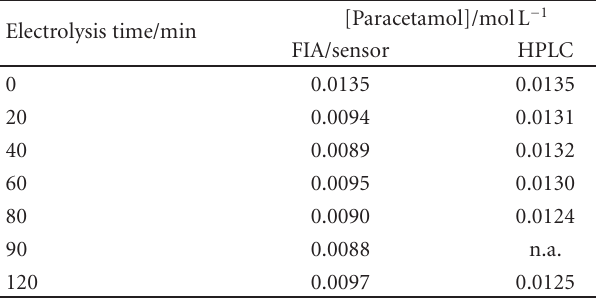
Table 1: Values of the concentration of paracetamol in the elec- trochemical degradation with DSA-Cl 2 anode at 5A cm − 2 , obtained through the method FIA with amperometric detector (biomimetic sensor) and chromatography